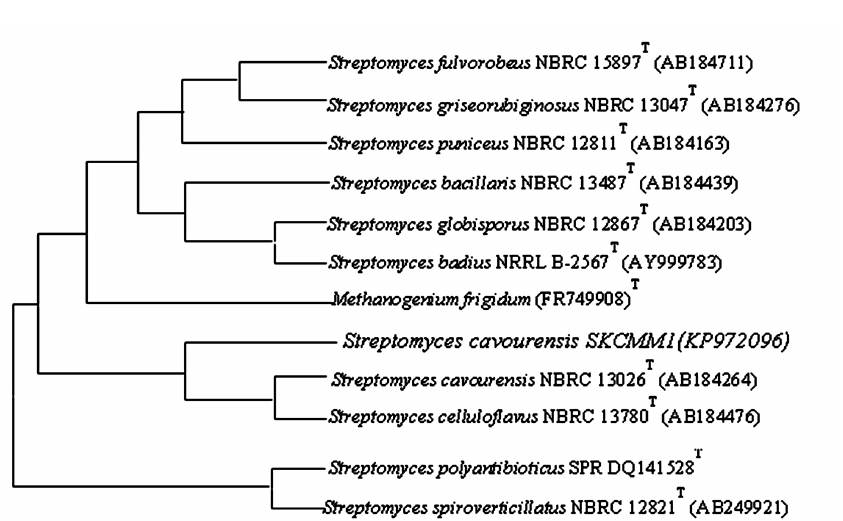
Fig. 4. Neighbor-joining phylogenetic tree based on 16S rRNA gene sequences showing the relationships of strain SKCMM1 with related